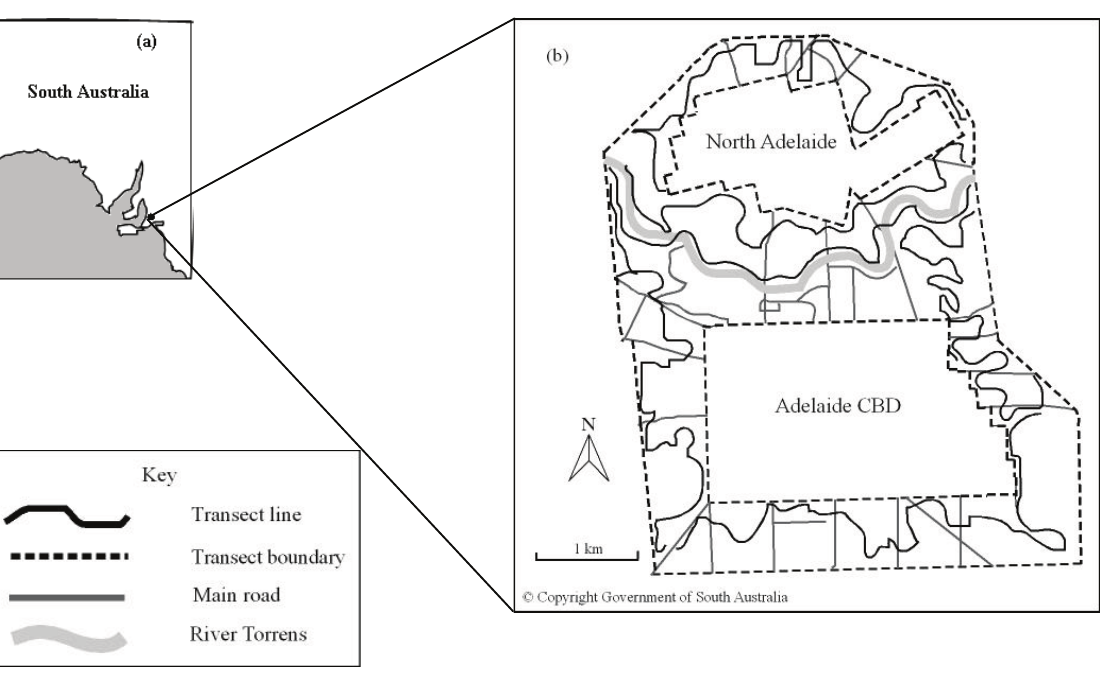
Figure 1. ( a ) Map of South Australia indicating Adelaide City [22]. ( b ) Bird survey transects in the Adelaide City parklands